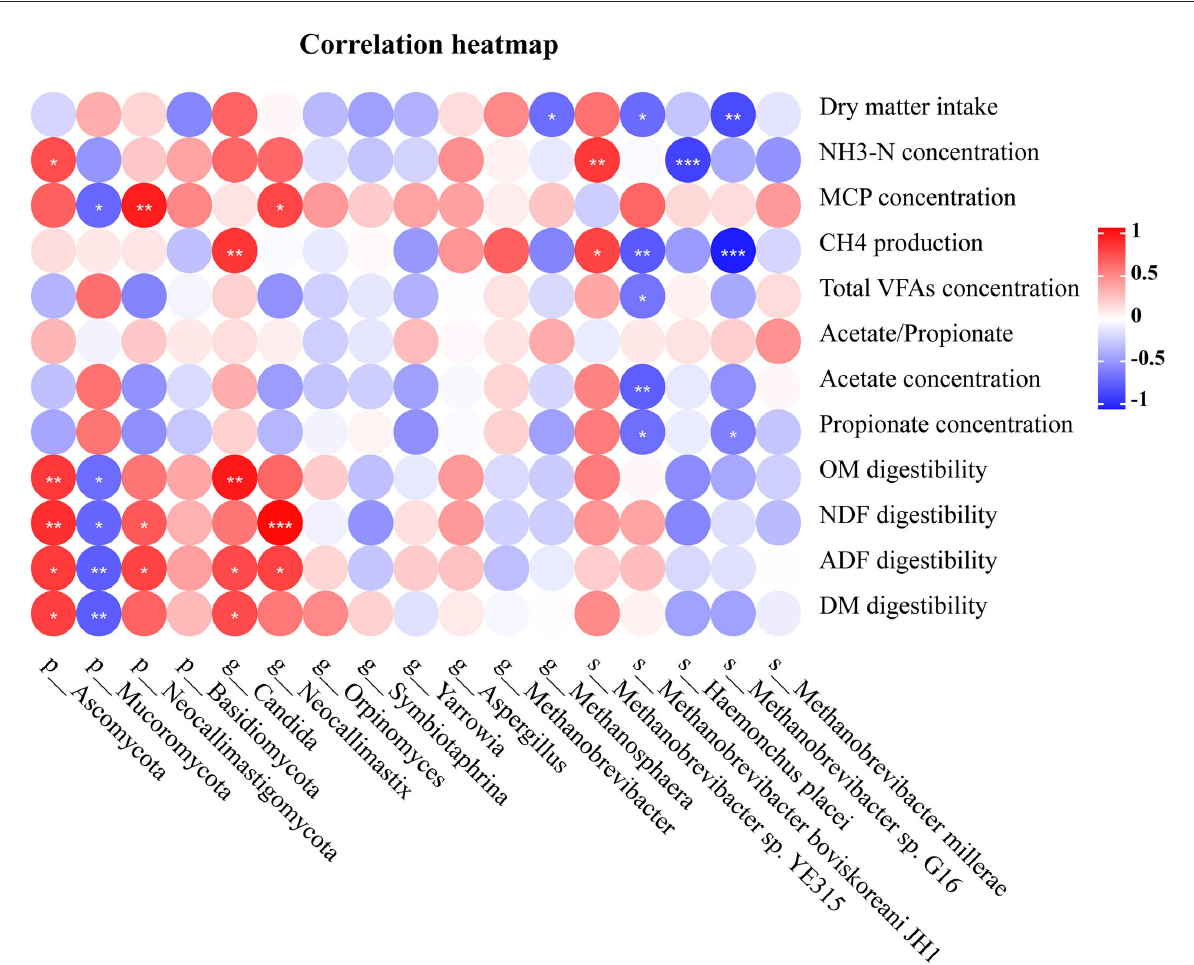
FIGURE5 The correlation of dry matter intake, rumen fermentation parameters and nutrient digestibility with microbial abundance. The colors indicate positive (red, closer to 0.81) or negative (blue, closer to − 0.90) correlations.